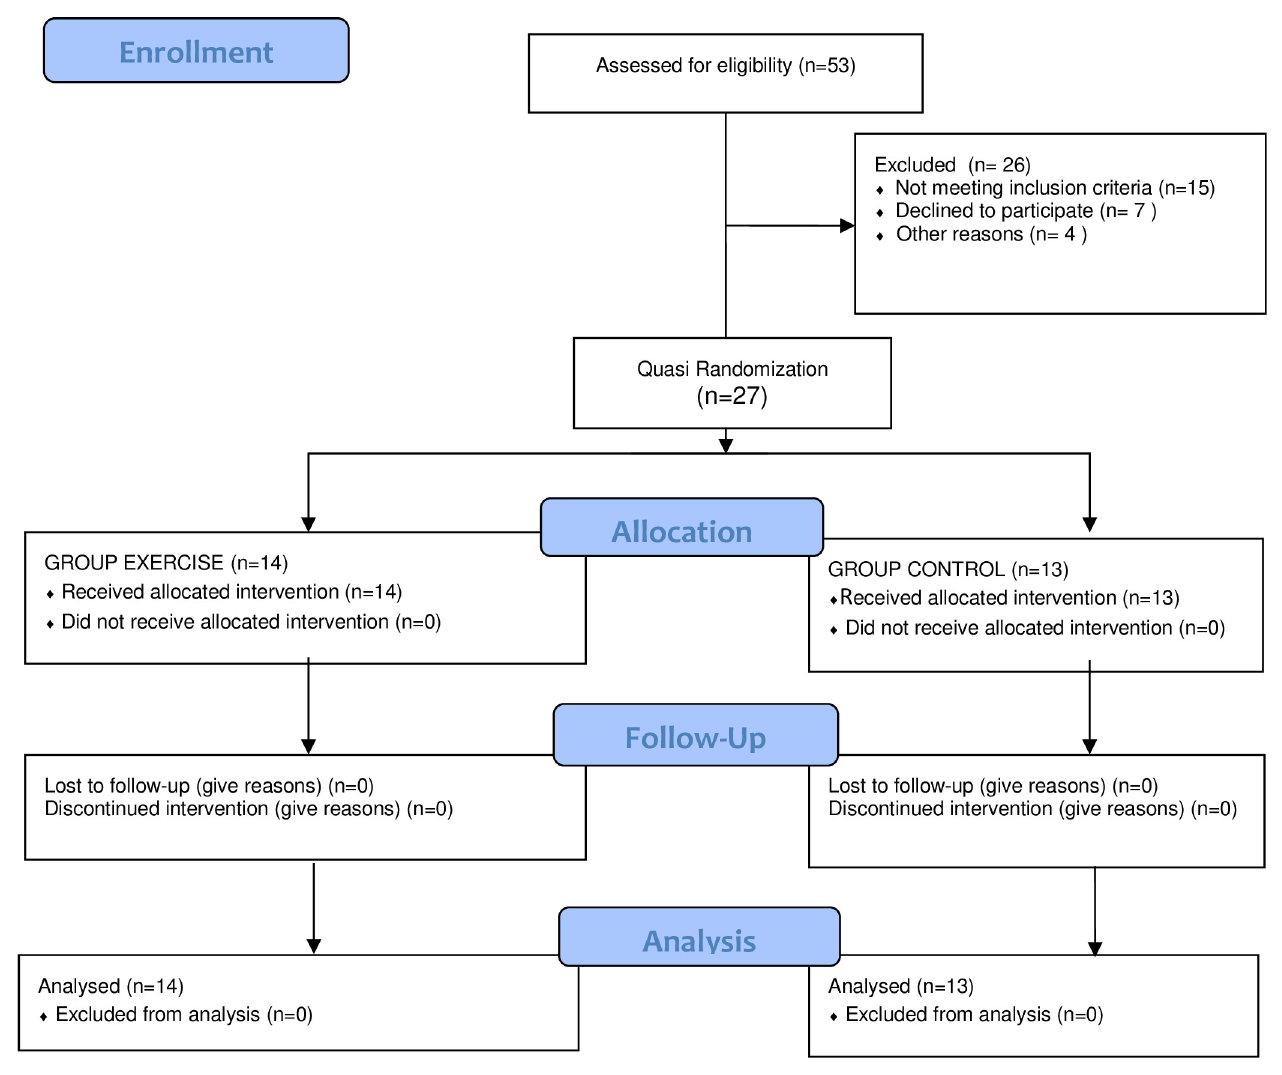
Fig 1. CONSORT 2010 flow